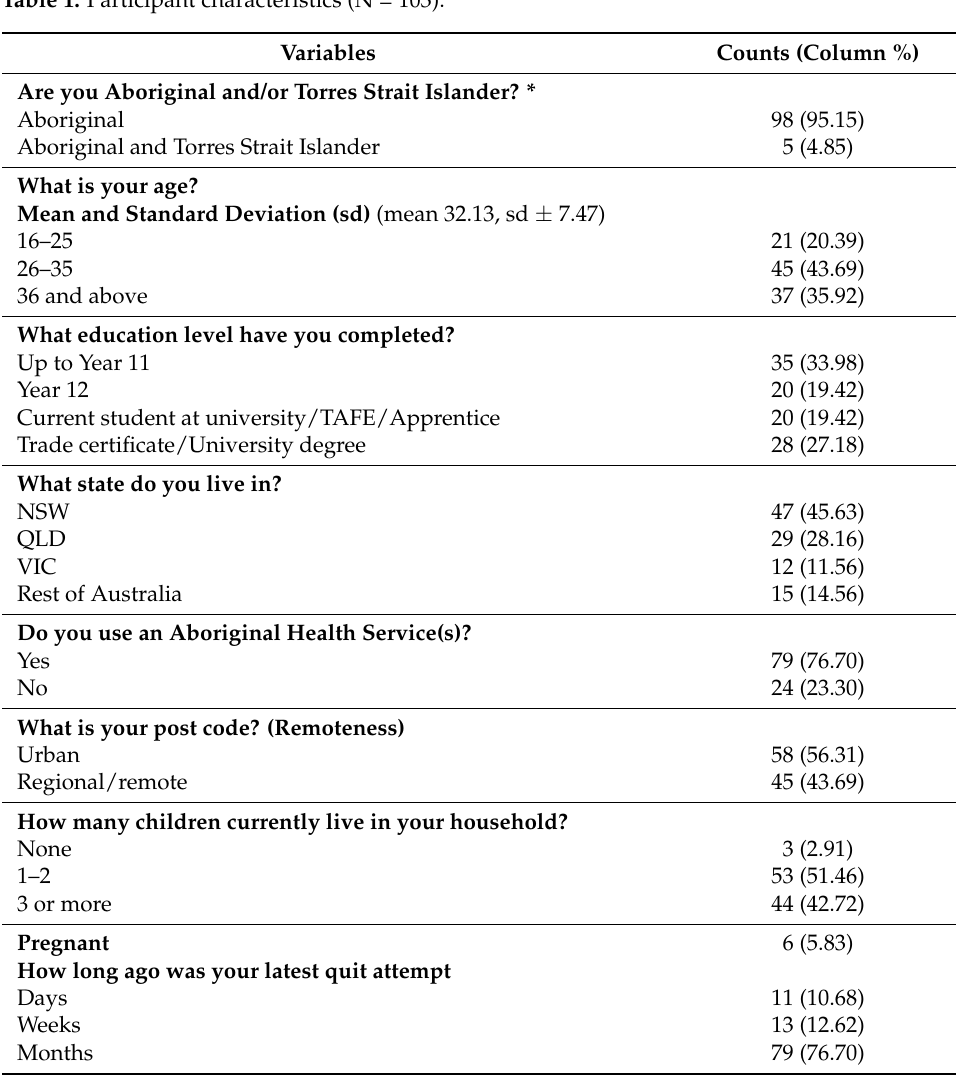
Table 1. Participant characteristics (N =